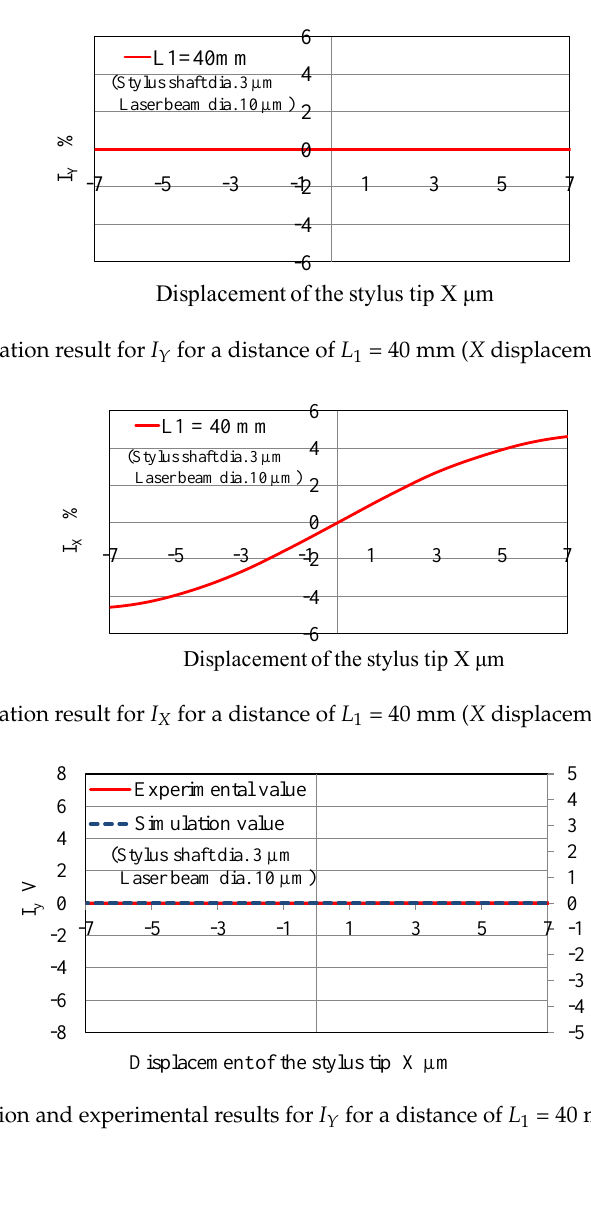
Figure 15. Simulation and experimental results for I X for a distance of L 1 = 40 mm ( X displacement of the stylus tip). 6. Evaluation of Measurement Resolution An experiment was conducted to evaluate the measurement resolution of the fiber probe. The changes in an output signal I X in the X direction were examined when the stylus tip was displaced by 3 and 10 nm steps in the X direction. The resolution of the stage in the X direction was 1 nm. Figure 16 shows the experimental apparatus used to evaluate the measurement resolution. Figure 17a,b show the output voltage I X induced by displacements of 3 nm and 10 nm in the step feeding of the stage in the +X direction. The horizontal axis shows the measurement time and the vertical axis shows the changes in the output signal I X in the X direction. It is possible to distinguish the 3 nm step, which shows that the measurement resolution of this system is approximately 3 nm. To improve the measurement resolution, it is necessary to reduce noise, develop a signal processing method, and use a high-power and stabilized laser diode. As for repeatability and more details on stylus performance, please refer to [28].